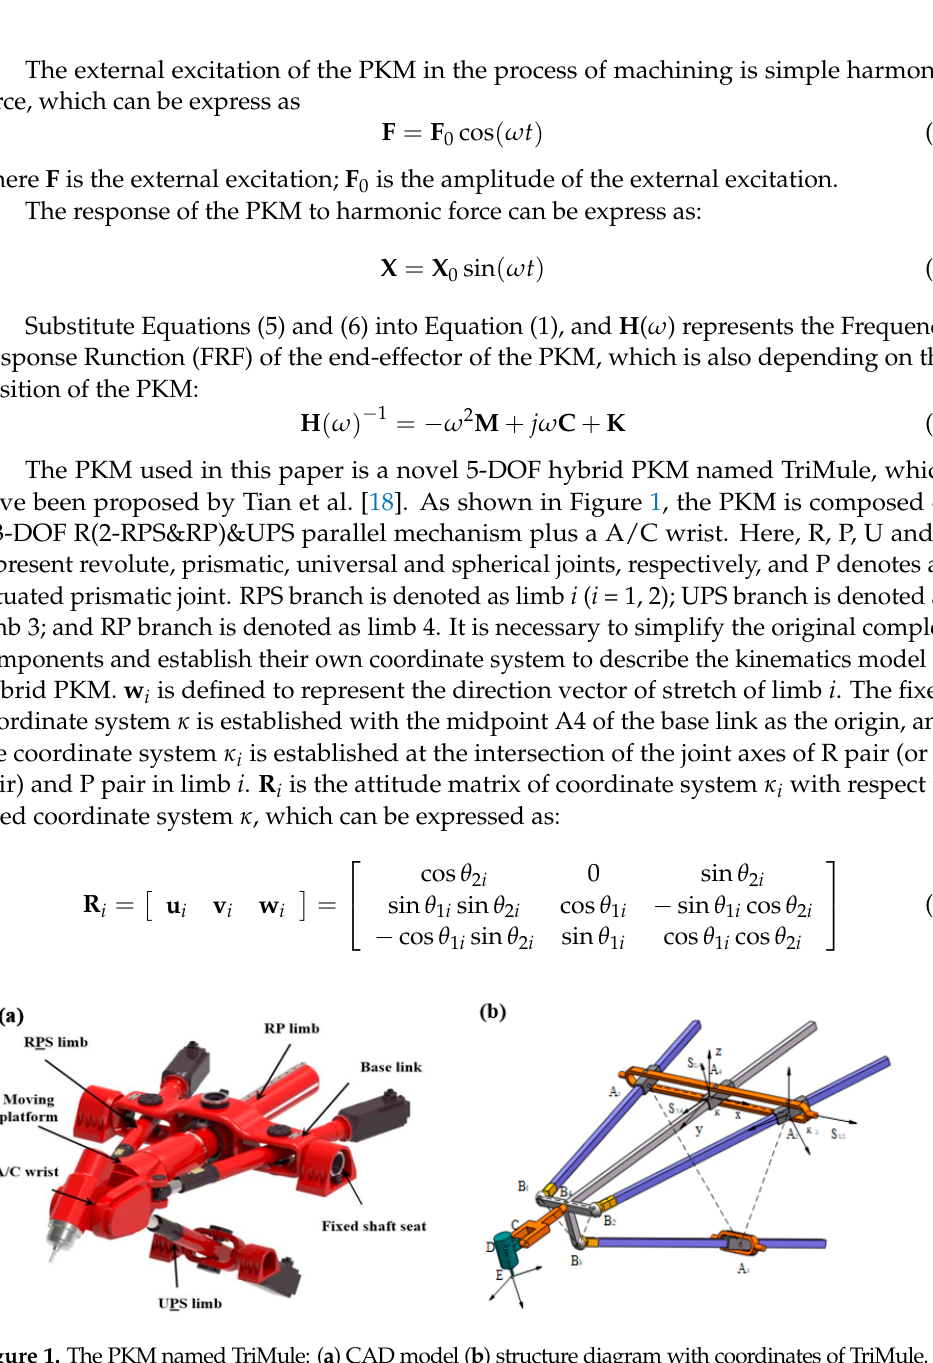
Figure 1. The PKM named TriMule: ( a ) CAD model ( b ) structure diagram with coordinates of TriMule.